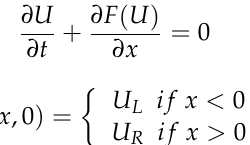
Figure 6. Initial data for the Riemann problem for the first-order solution.